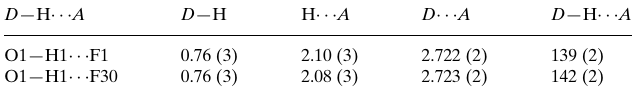
Hydrogen-bond geometry (A˚ , (cid:2)